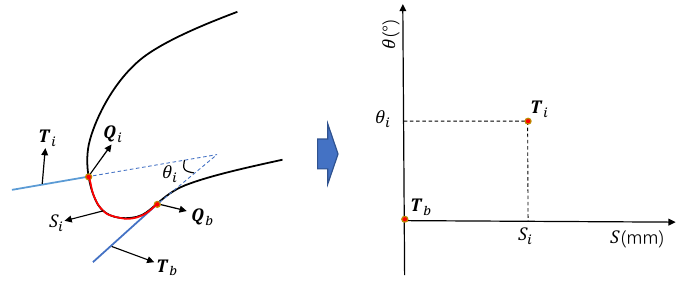
Figure 3. Mapping of tool orientation in the S - θ plane.